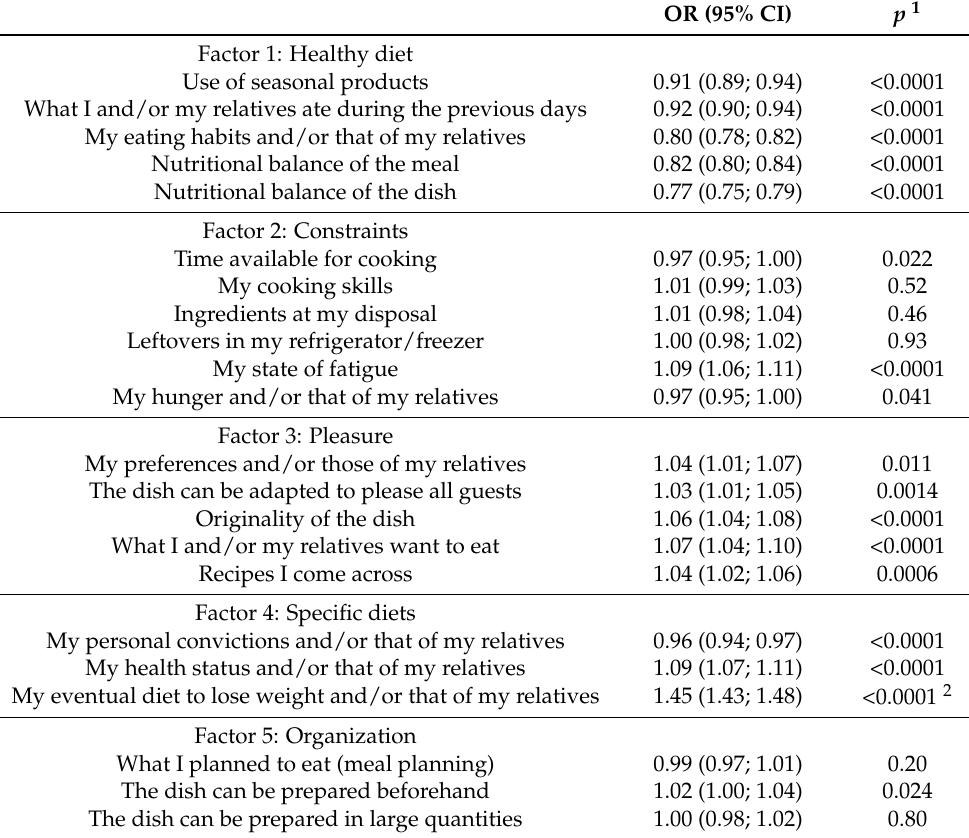
Table 4. Multivariate logistic regression analyses showing the association between criteria related to dish choice motives and overweight (including obesity) in weekdays ( n = 50,003; NutriNet-Santé cohort